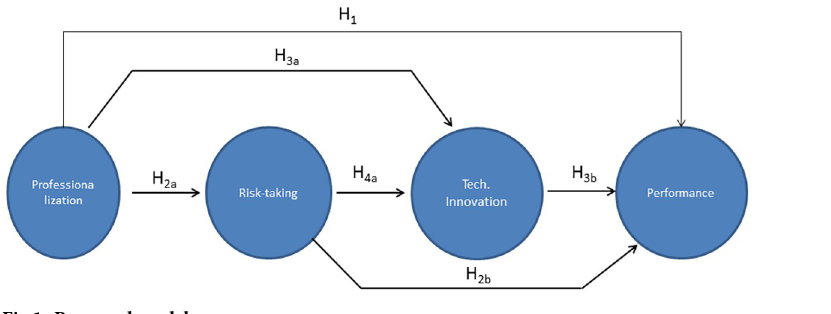
Fig 1. Proposed model.